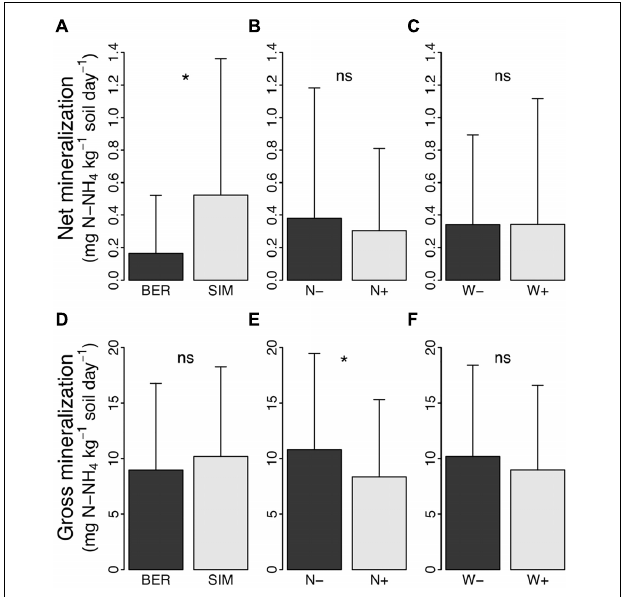
(C–F) warmed (W+) vs. unwarmed (W-) plots. * and ns indicate a significant ( P < 0.05) and not significant difference, respectively.